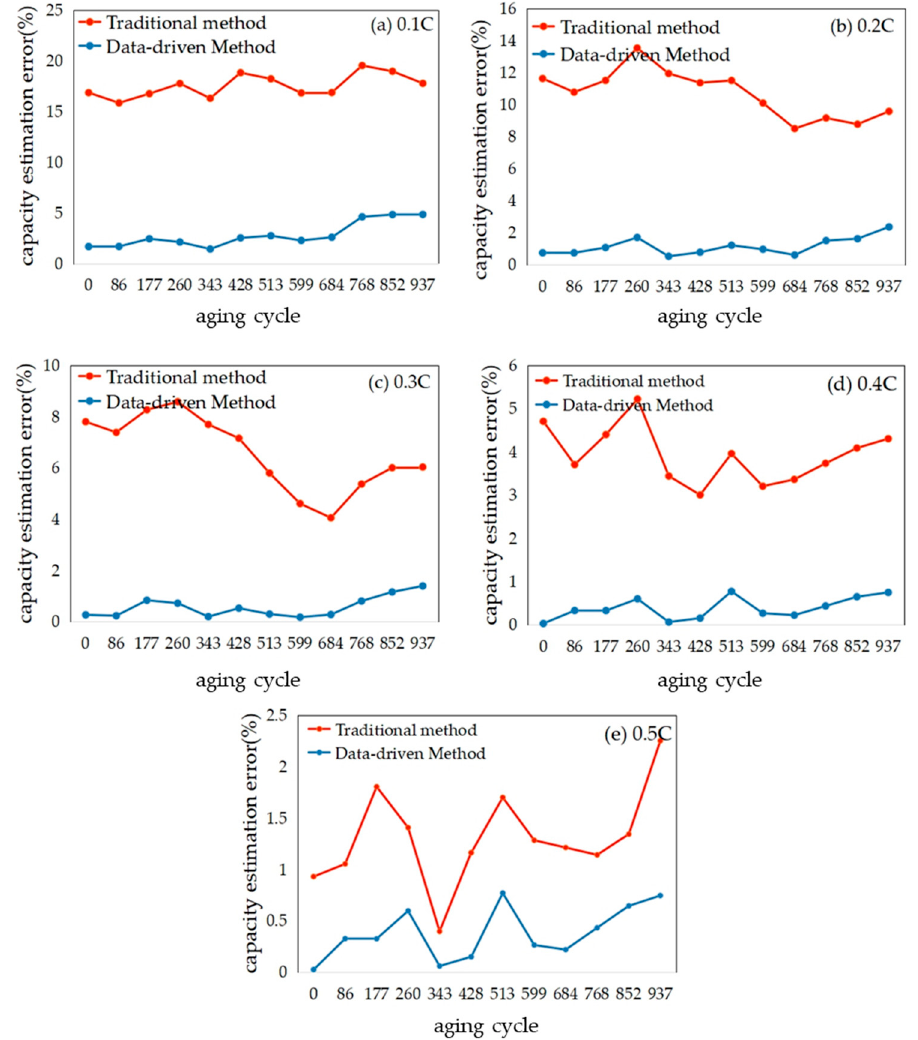
Figure 7. Accuracy comparison of the traditional method and data-driven method.